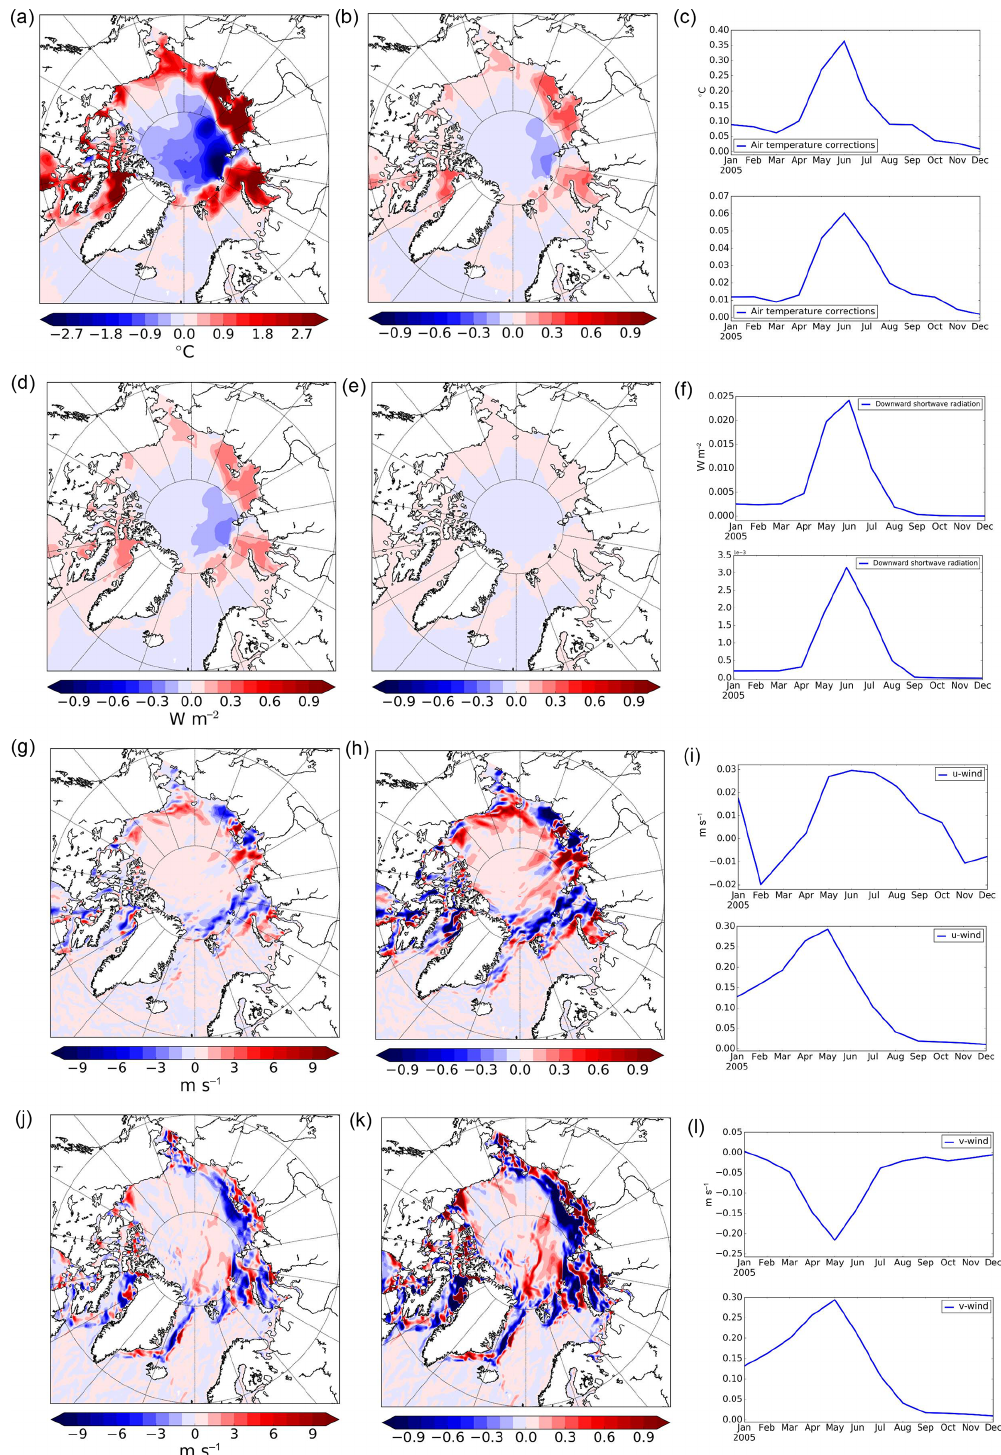
Figure 8. Corrections for different surface forcing variables: spatial distribution (a, d, g, j) and spatial distribution scaled by the uncertainty (b, e, h, k) for the month with the largest absolute value of corrections in 2005. Also shown is the monthly climatology for the sea ice area-mean corrections (c, f, i, l) averaged over the area north of 66.5 ◦ N (top panels for each variable) and the average of absolute values scaled by the uncertainties (lower panel for each variable). Corrections are shown for June 2005 2m air temperature (a–c) , June 2005 downward shortwave radiation (d–f) , June 2005 zonal component of the wind (g–i) and May 2005 meridional component of the wind (j–l) .